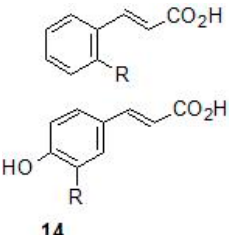
Figure 8. General chemical structures ferulic and coumaric acids ( 14 ).